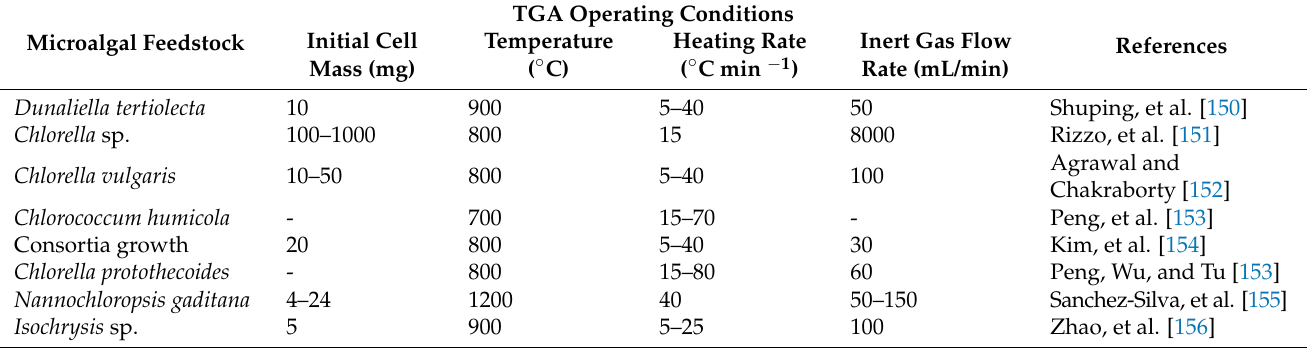
Table 5. TGA-analysis condition for energy kinetics study of different microalgal strains.